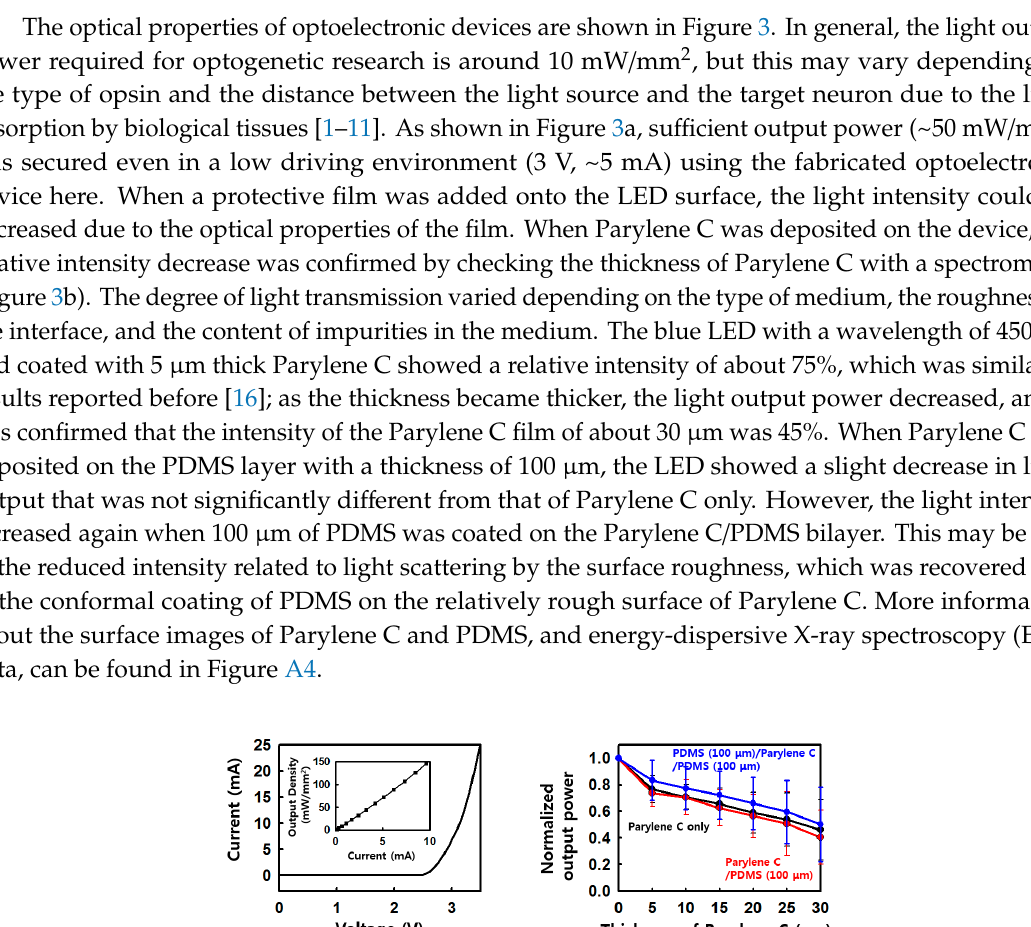
Figure 2. Images of fabricated soft optogenetic devices. ( a ) Photograph of wirelessly operated optoelectronic device on near-field communication (NFC) reader; ( b ) microscopic image of laser-cut aluminum (Al) antenna.